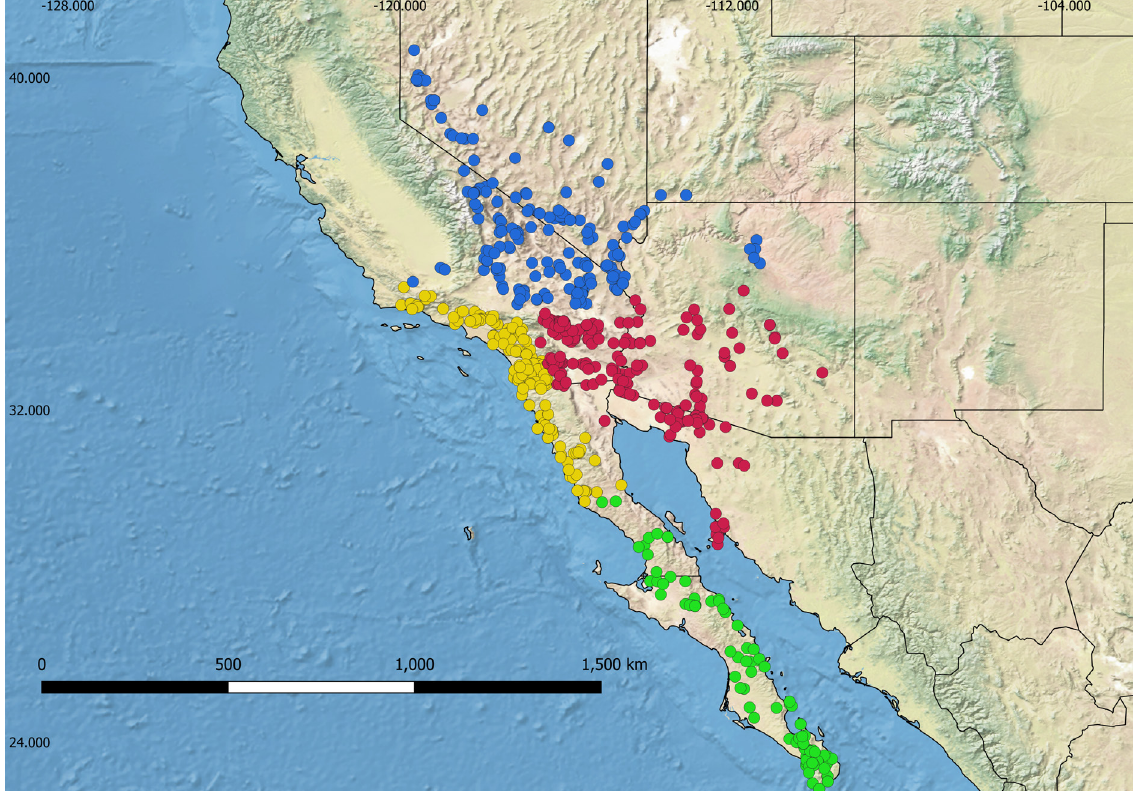
Fig. 9. Locality records of Salvadora hexalepis (Cope, 1866) and its subspecies. Blue dots represent S. h. mojavensis Bogert, 1945; yellow dots S. h. virgultea Bogert, 1935; red dots S. h. hexalepis (Cope, 1866) and green dots S. h. klauberi